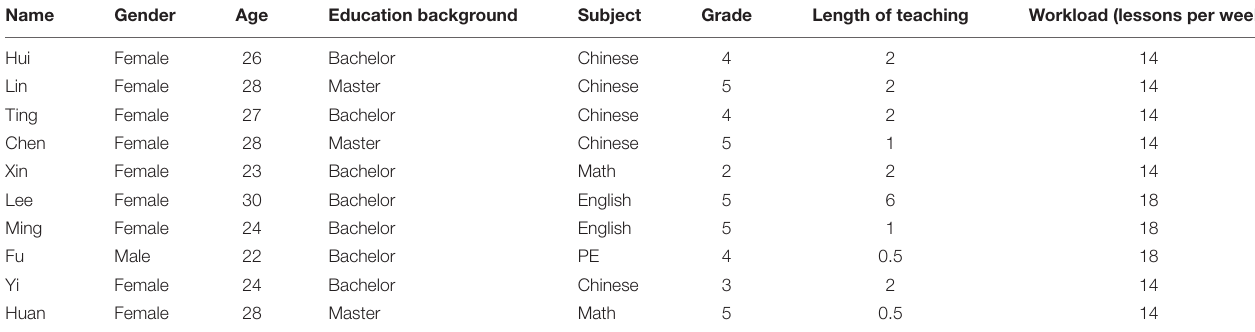
TABLE 1 | The basic information of teacher